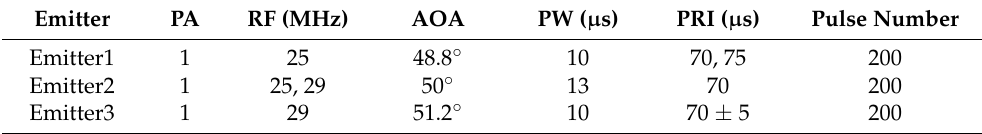
Table 8. Signal parameters of simulation